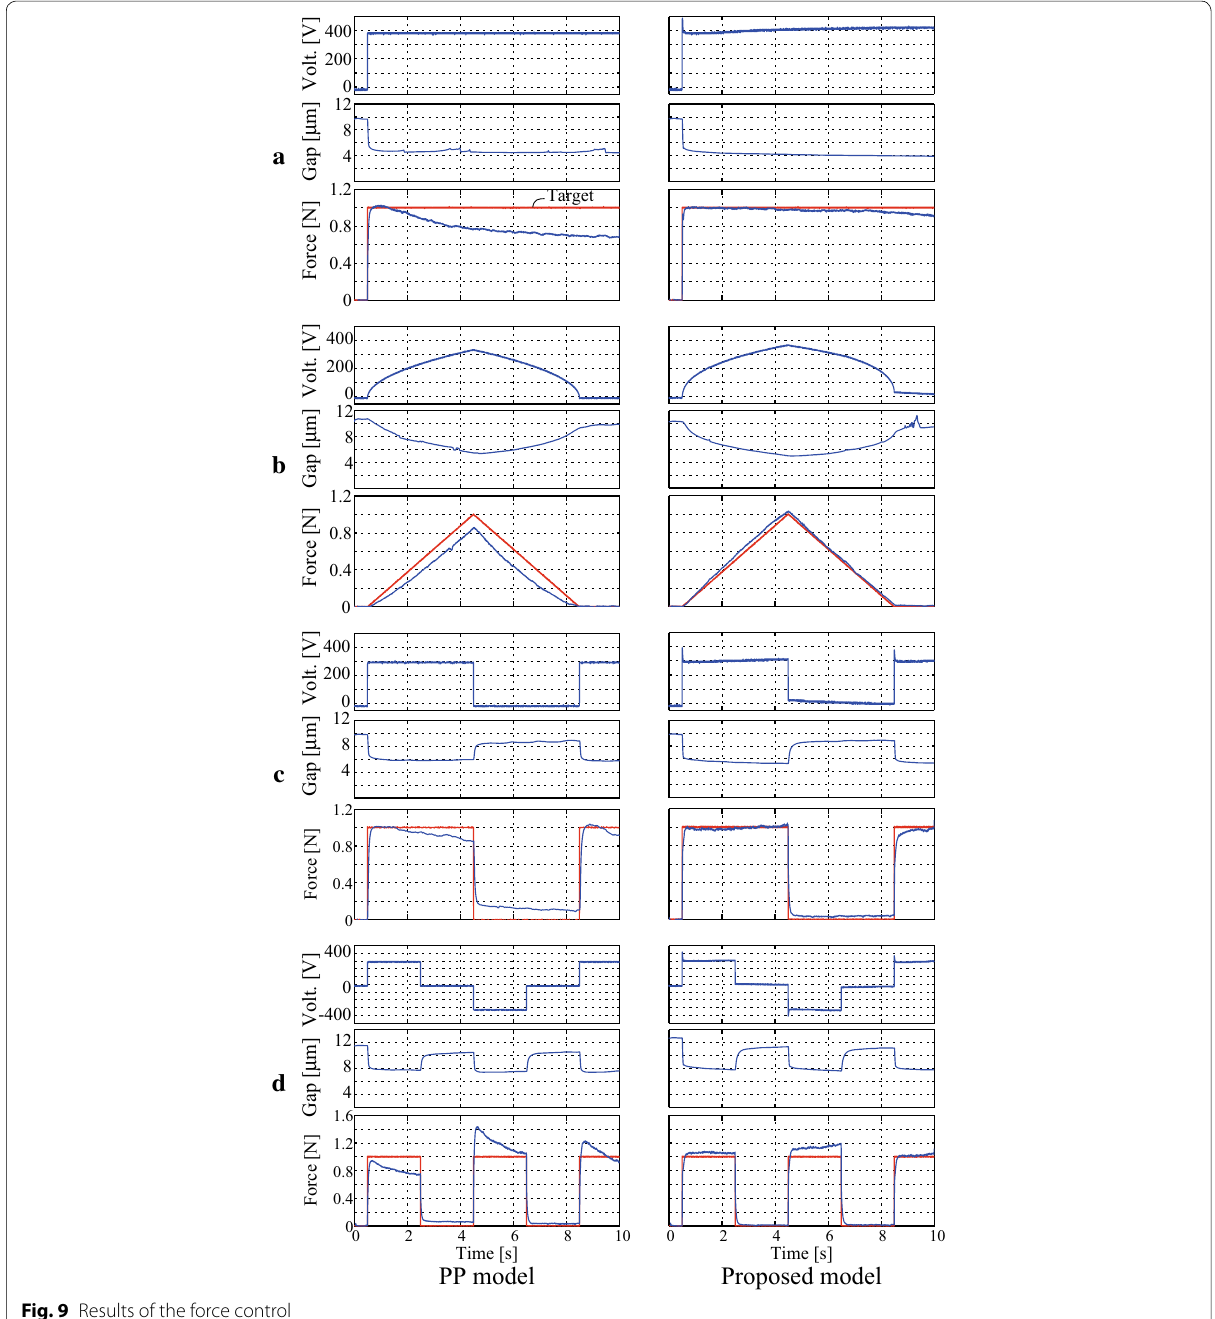
Fig. 9 Results of the force